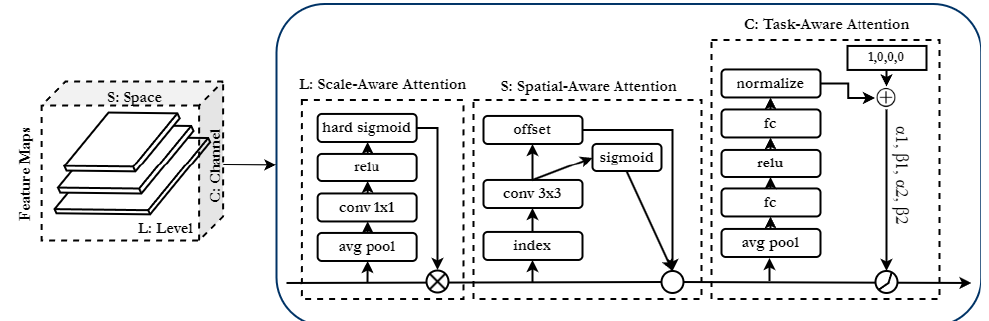
Figure 5. Overview of the neck implementing the disentanglement head. The individual attention mechanisms are enclosed within dashed boxes, and together, they form a single block represented by the solid box. The directed solid line indicates the sequence of processing, and the circles represent the functions applied within each attention. In task-aware attention, the initial values of [ α 1, β 1, α 2, β 2 ] = [1,0,0,0] are concatenated with the normalised data and finding the maximum between the piecewise functions involving α 1, β 1, α 2, β 2 and the input tensor.